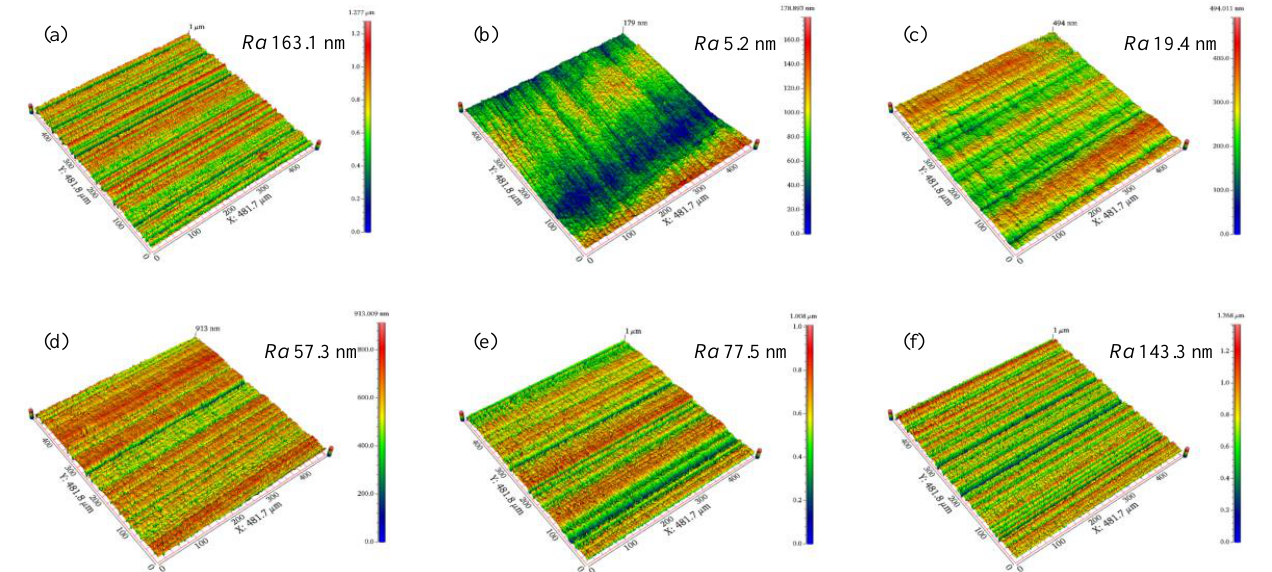
Figure 12. Micrographs and 3D micro-topography images of flank face. ( a ) initial, Ra 163.1 nm, ( b ) − 20°, Ra 5.2 nm, ( c ) − 10°, Ra 19.4 nm, ( d ) − 0, Ra 57.3 nm, ( e ) 10°, Ra 77.5 nm, ( f ) 20°, Ra 143.3 nm.